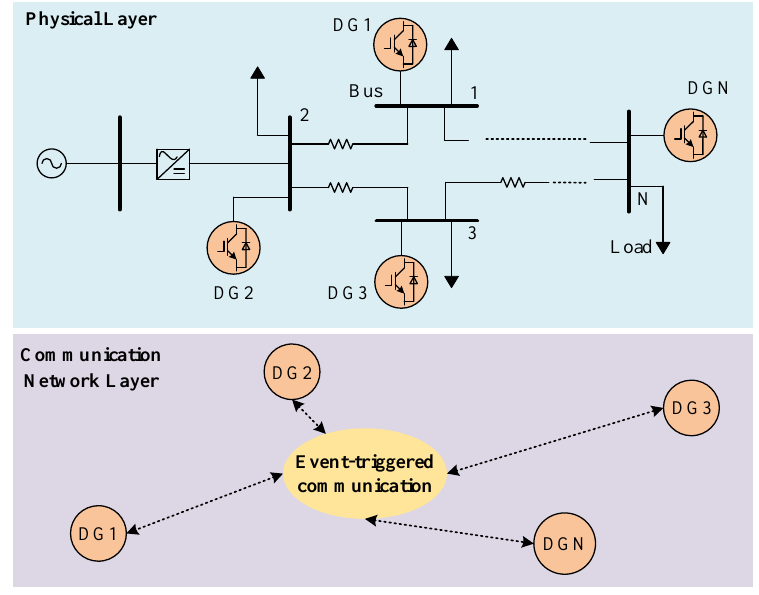
Figure 1. Distributed control